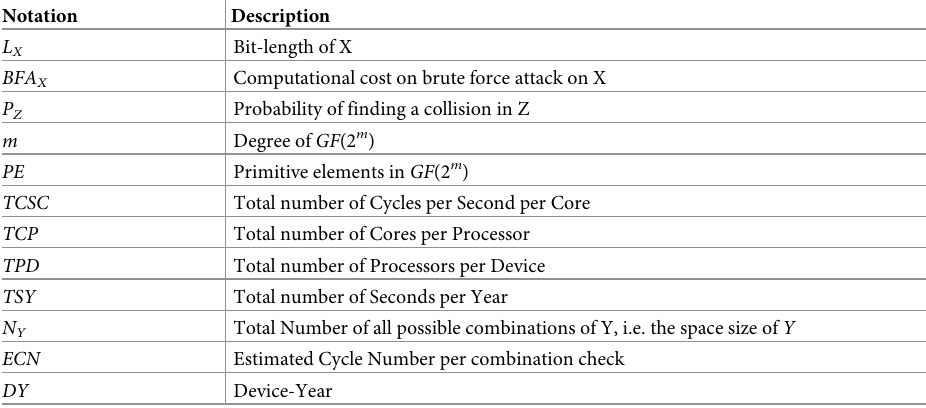
Table 6. Notations used in the security